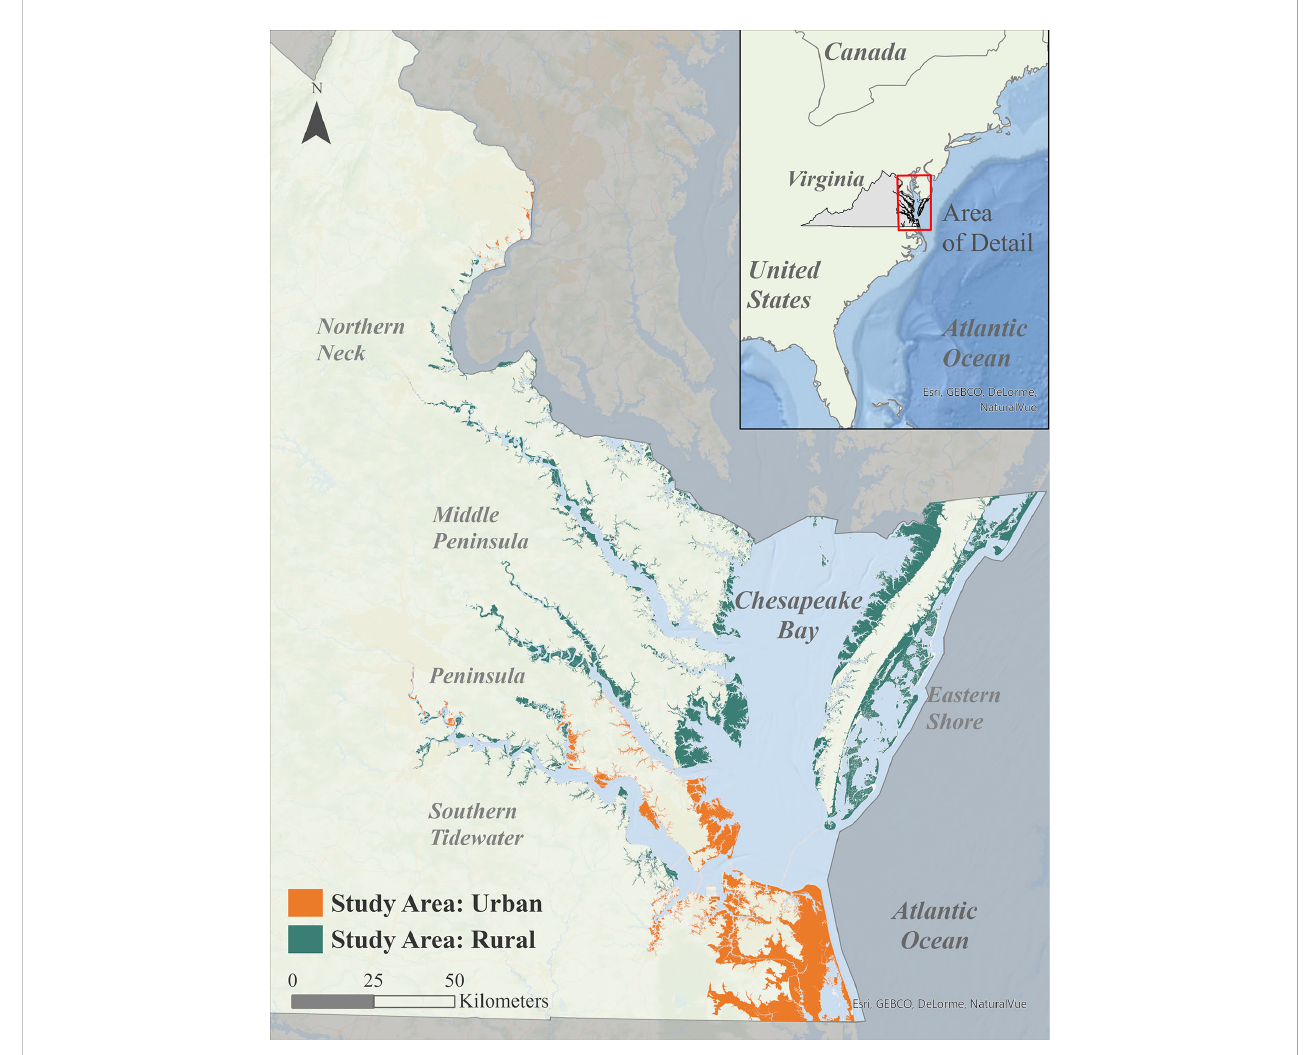
FIGURE 1 Map of study area with regions, and urban and rural areas denoted. (Imagery source: Esri, DigitalGlobe, GeoEye, i-cubed, USDA FSA, USGS, AEX, Getmapping, Aerogrid, IGN, IGP, swisstopo, and the GIS User